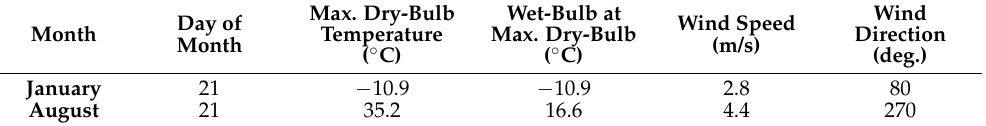
Table 6. Parameters of the design days in EnergyPlus.